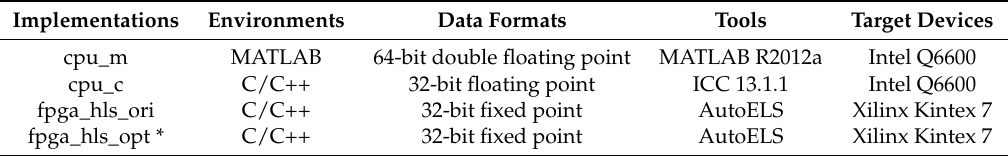
Table 2. Implementation specifications: “ * ” indicates the proposed